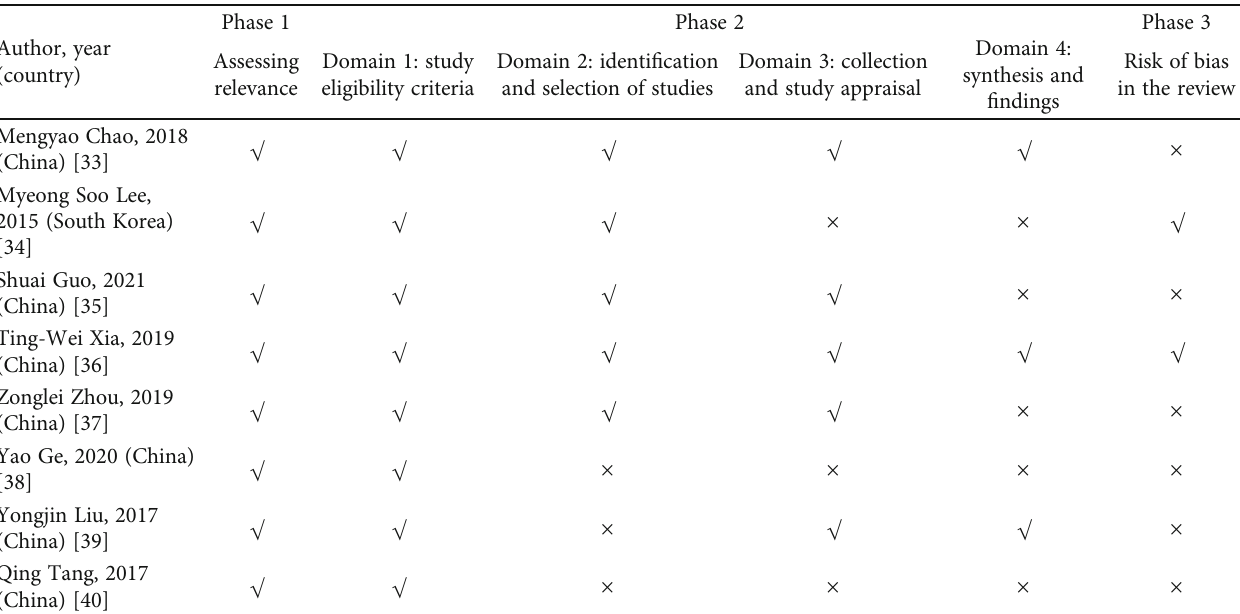
Table 4: Results of the ROBIS assessments. Note: √ : low risk; × : high risk.